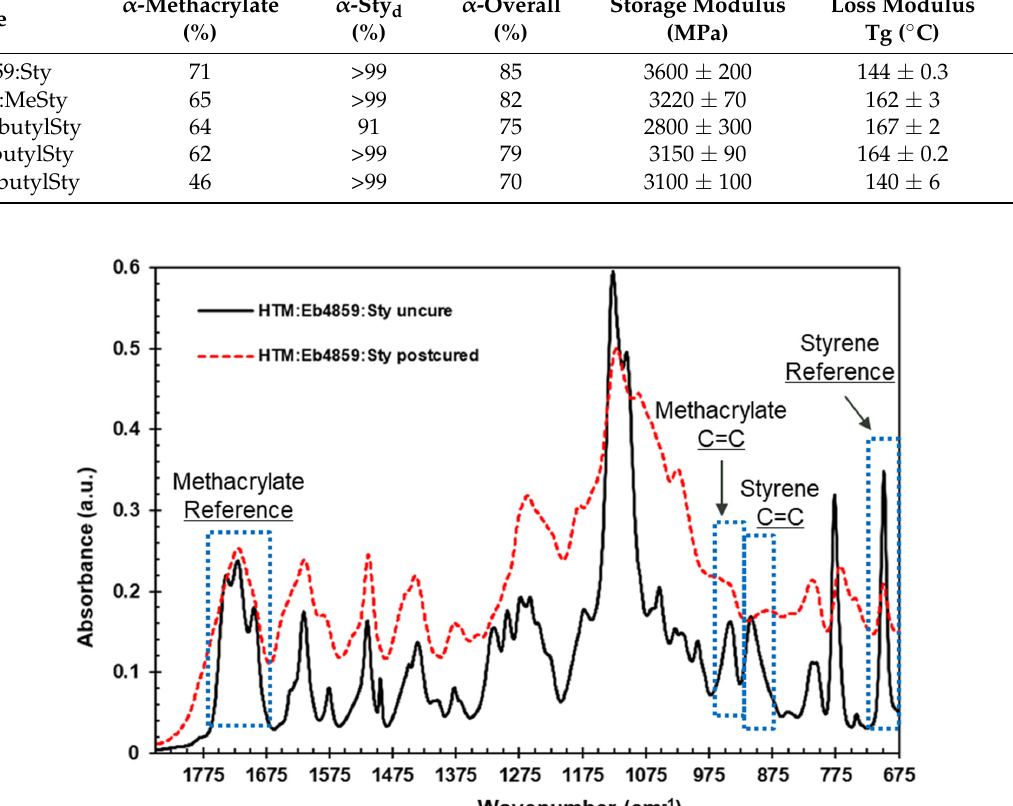
Figure 10. FTIR-ATR spectrum of ternary HTM:Eb4859:Sty (2:1:2) uncured resin and post-cured 3D printed thermoset. Table 6. Extent of cure and thermomechanical properties of 3D printed HTM ternary thermosets.